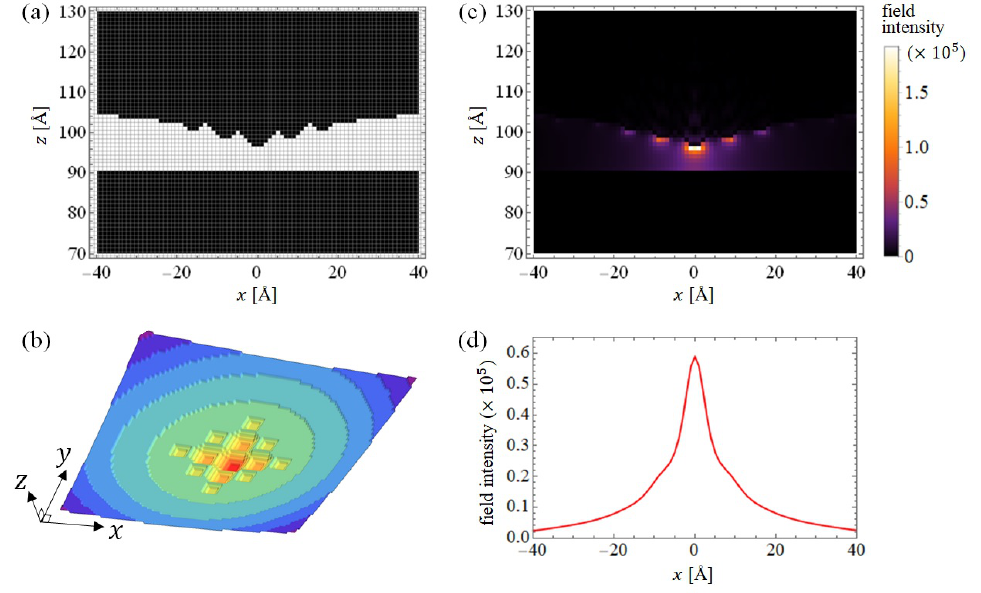
Figure 5. ( a , b ) show the model tip with picocavity in the cross-sectional picture of the tip center and the three-dimensional picture of the bottom view, respectively, in discretized space. The colors in ( b ) represent contour maps. ( c ) shows a map of the response field intensity from the viewpoint of ( a ). The intensity is determined as a ratio of the incident field, | E | 2 / | E 0 | 2 . ( d ) is the line profile of the field intensity at 3 Å below the tip